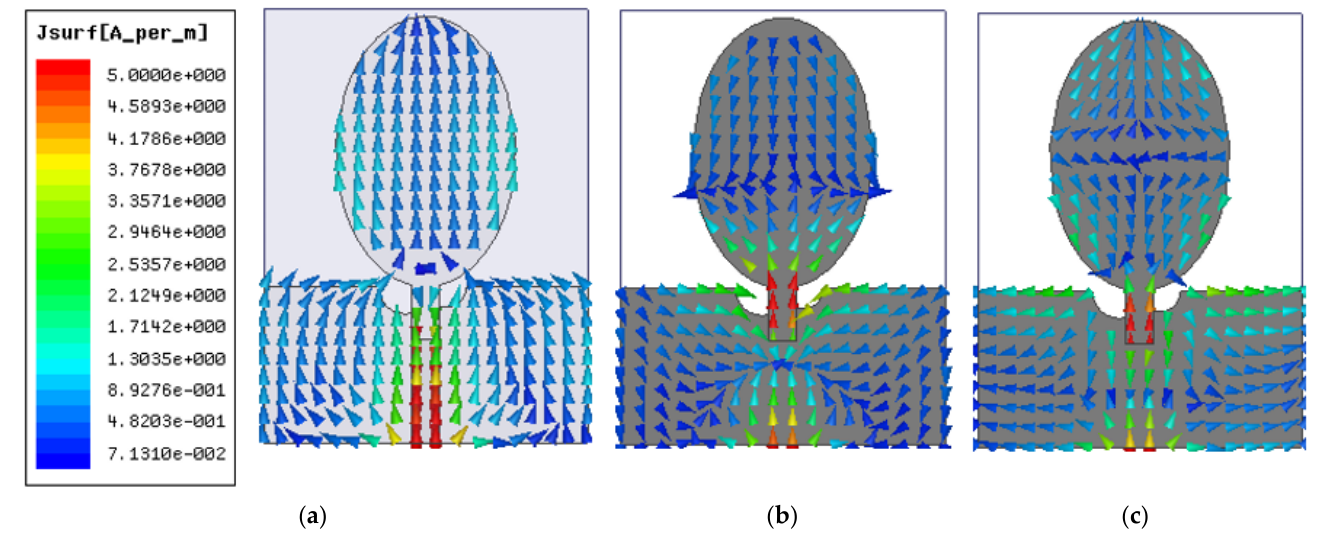
Figure 11. Current distribution at ( a ) 3.6 GHz, ( b ) 6.8 GHz, ( c ) 9.7 GHz.